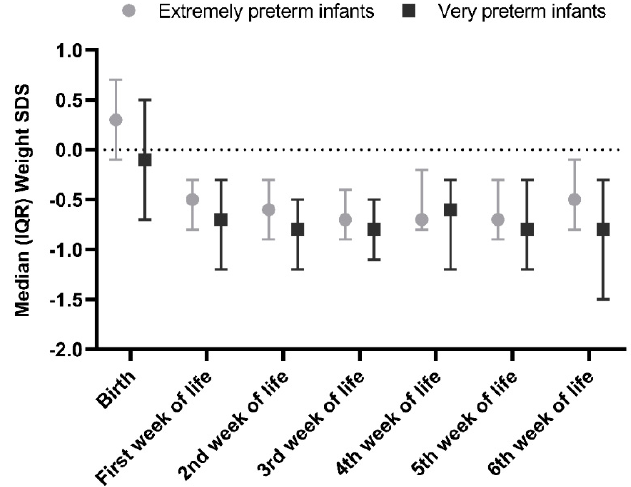
Figure 3. Weight SD score in extremely and very preterm infants.